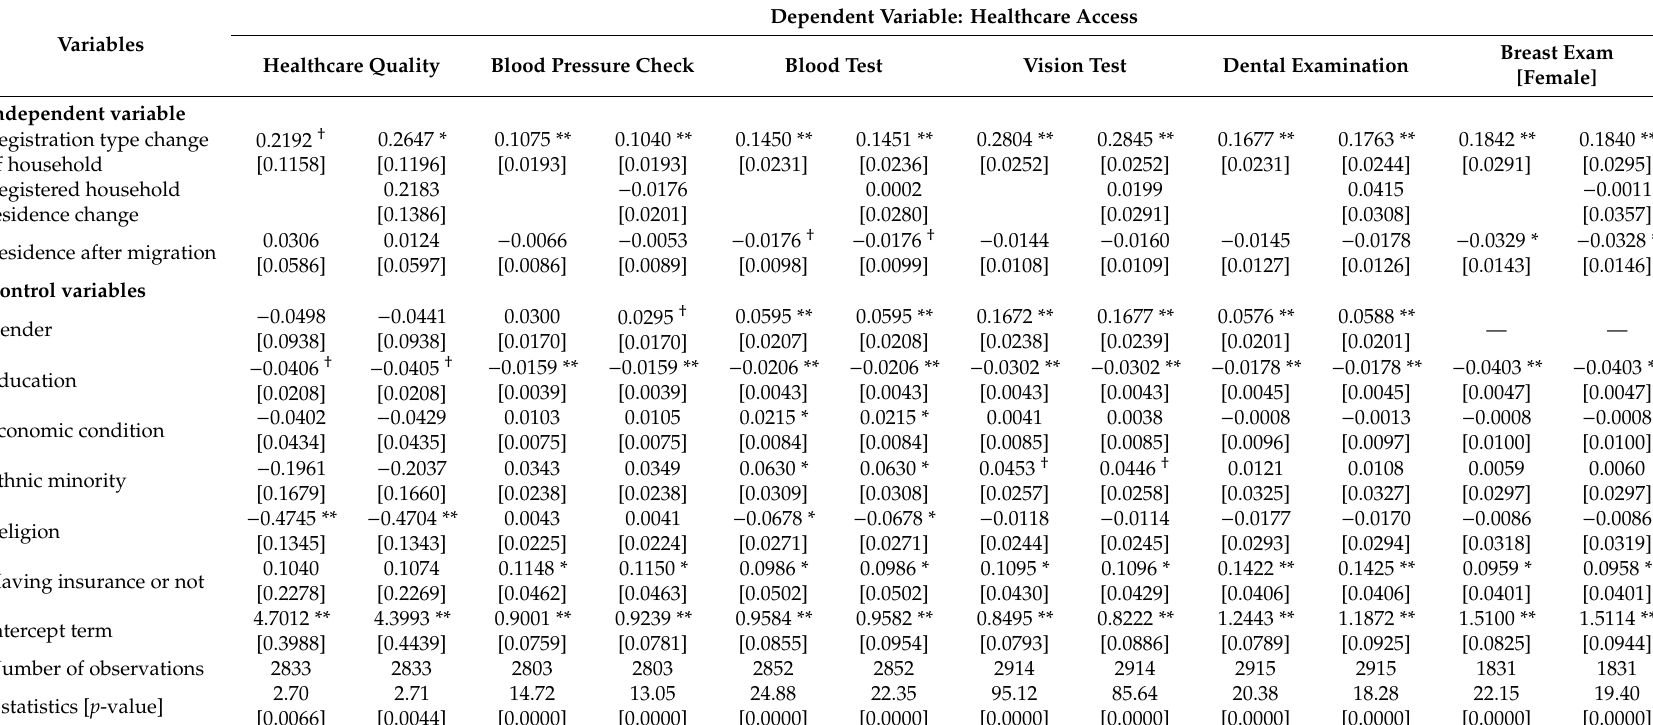
Table 4. E ff ects of household registration (hukou) change and migration on healthcare access for rural